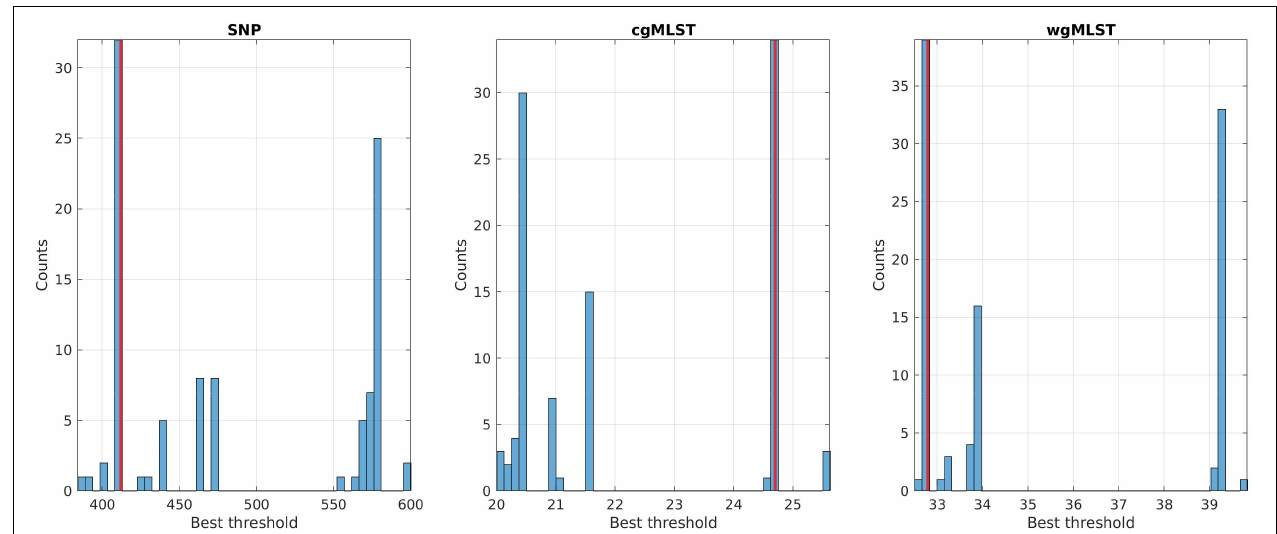
FIGURE 3 | Best threshold values obtained by the 70/30 cross-validation procedure on the training sets of SNP, cgMLST, and wgMLST distance matrices. The red line corresponds to the global best threshold value used for source clustering ( Figure 4 ) and source attribution ( Figure 5 ).